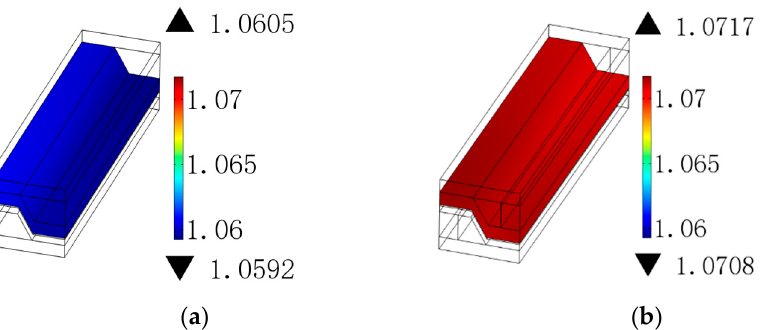
Figure 6. Anode potential distribution: ( a ) conventional design; ( b ) vertical rib design (unit: V) .